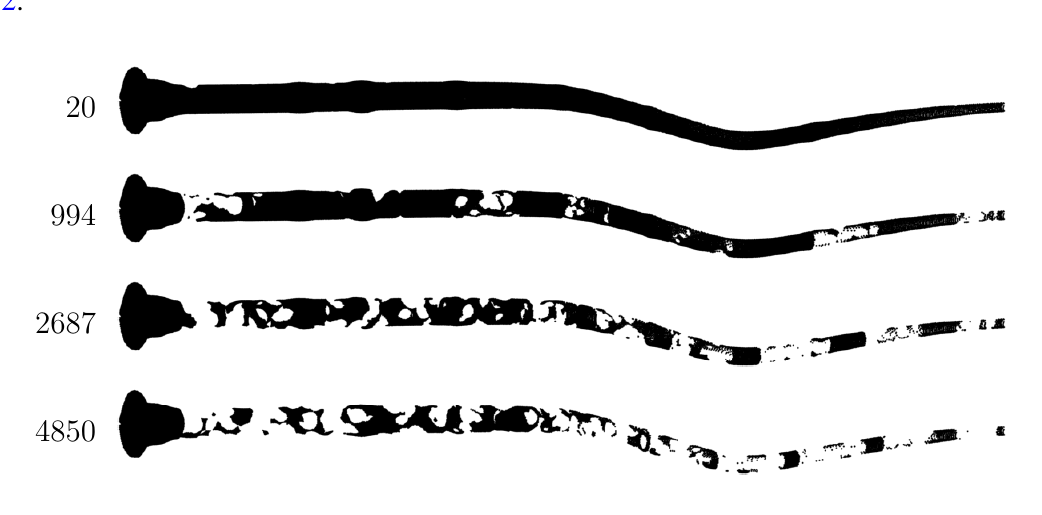
Figure 11. Example point clouds with increasing number of spherical section removals.